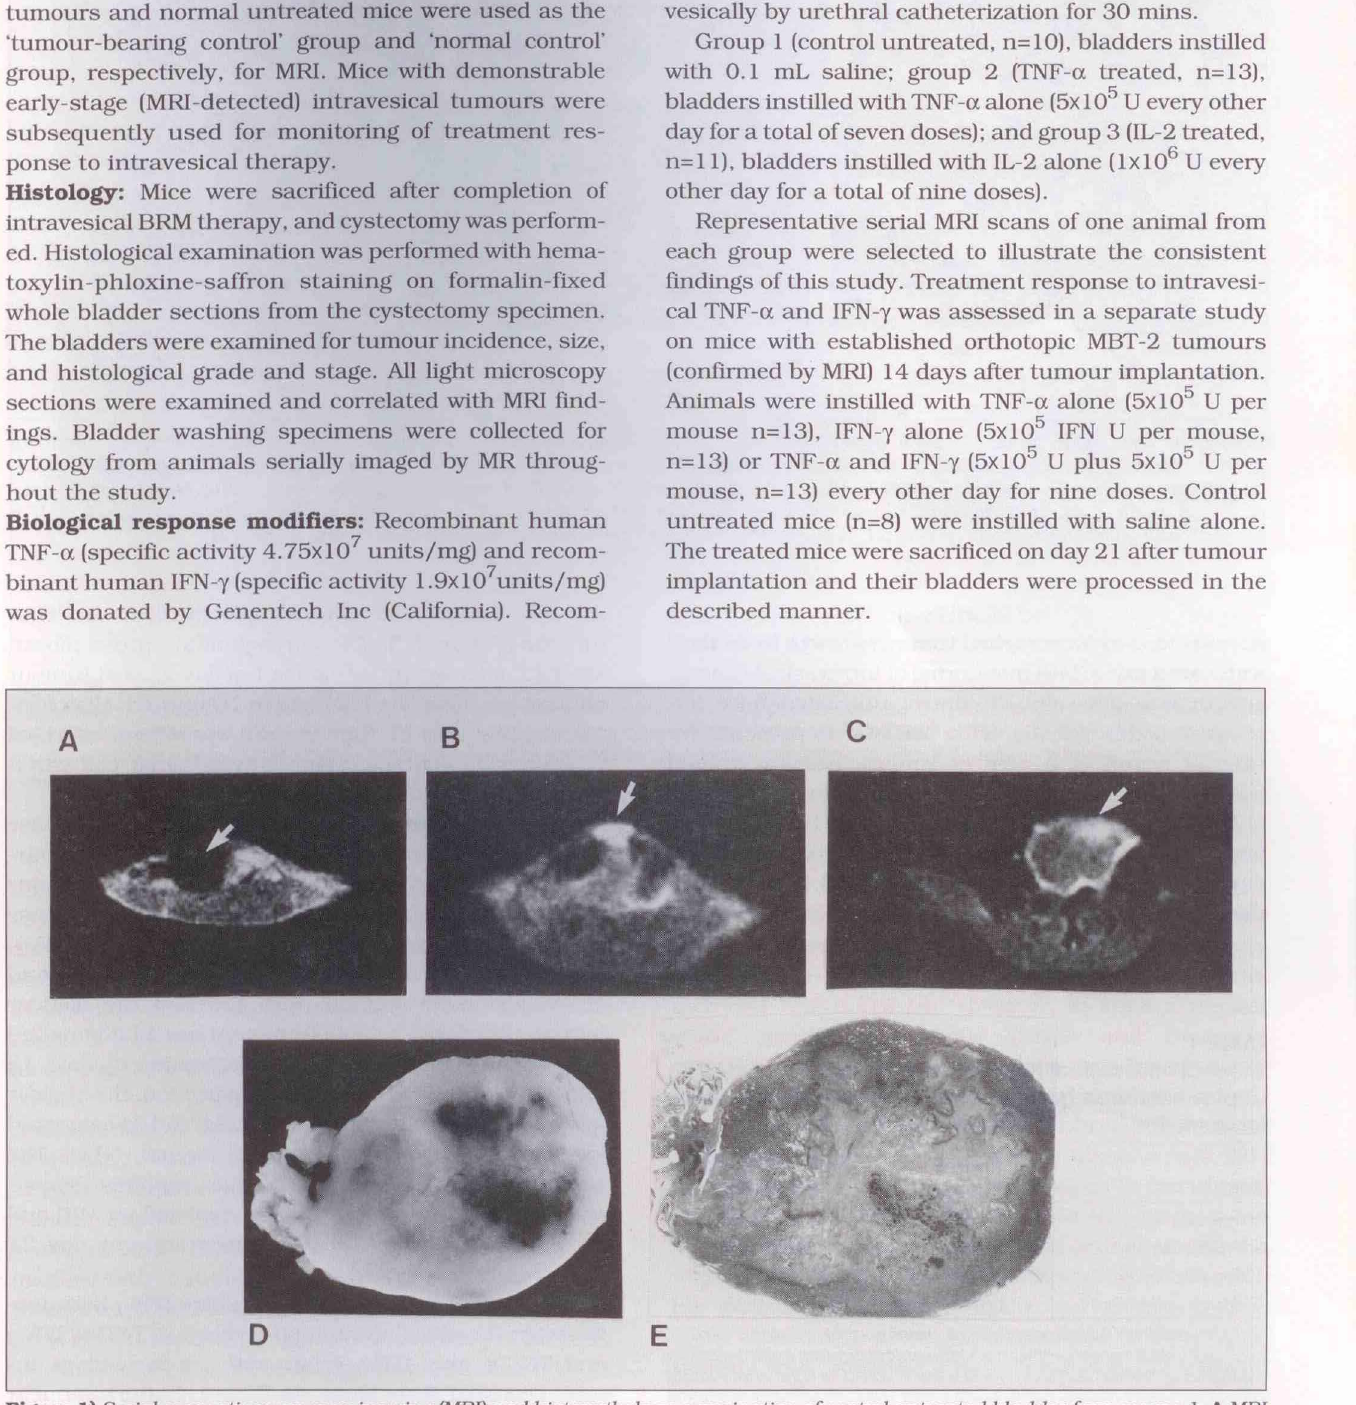
Figure 1) Serial magnetic resonance imaging {MRI) and histopathology examination of control untreated bladder from mouse 1. A MRI bladder six days post. tumour implant., no visible tumour (arrow); B MRI Bladder partially filled wit.h tumour (arrow) 18 days